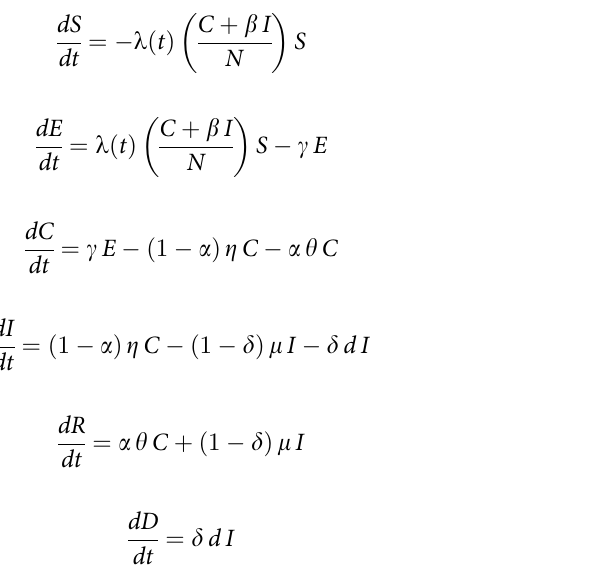
The meaning of the model parameters and their priors are detailed in S1 Table in S1 Text.